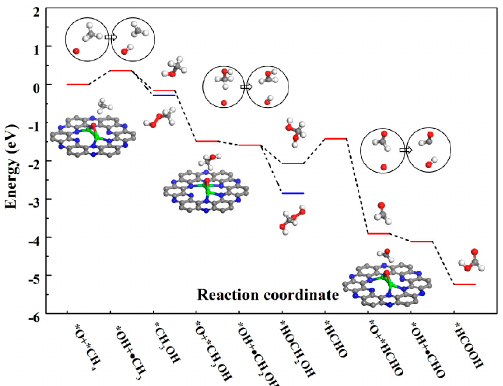
Figure 4. Potential energy diagram for methane oxidation on Fe-O-Fe active sites. The gray, blue, green, red and while balls represent C, N, Fe, O and H atoms.